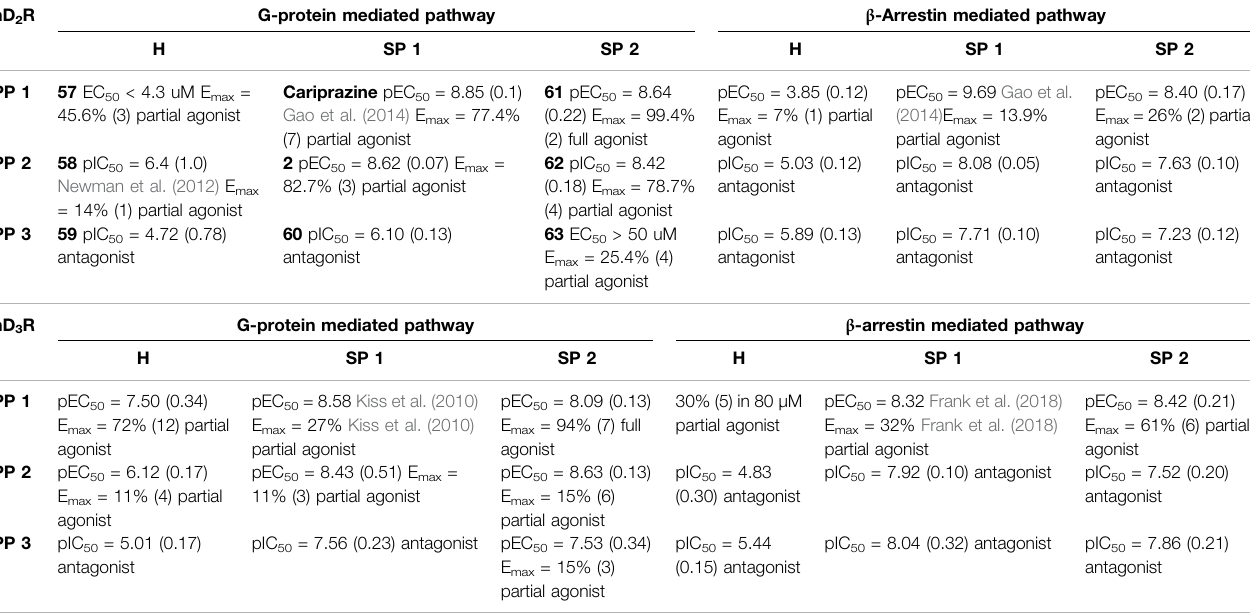
TABLE 3 | Functional activities (pIC 50 or pEC 50 and maximal ef fi cacy (Emax) values with s.d. values in parentheses) measured for the G-protein mediated and β -arrestin mediated pathway of the hD 2 and hD 3 receptor (Egyed et al., 2020). hD 2